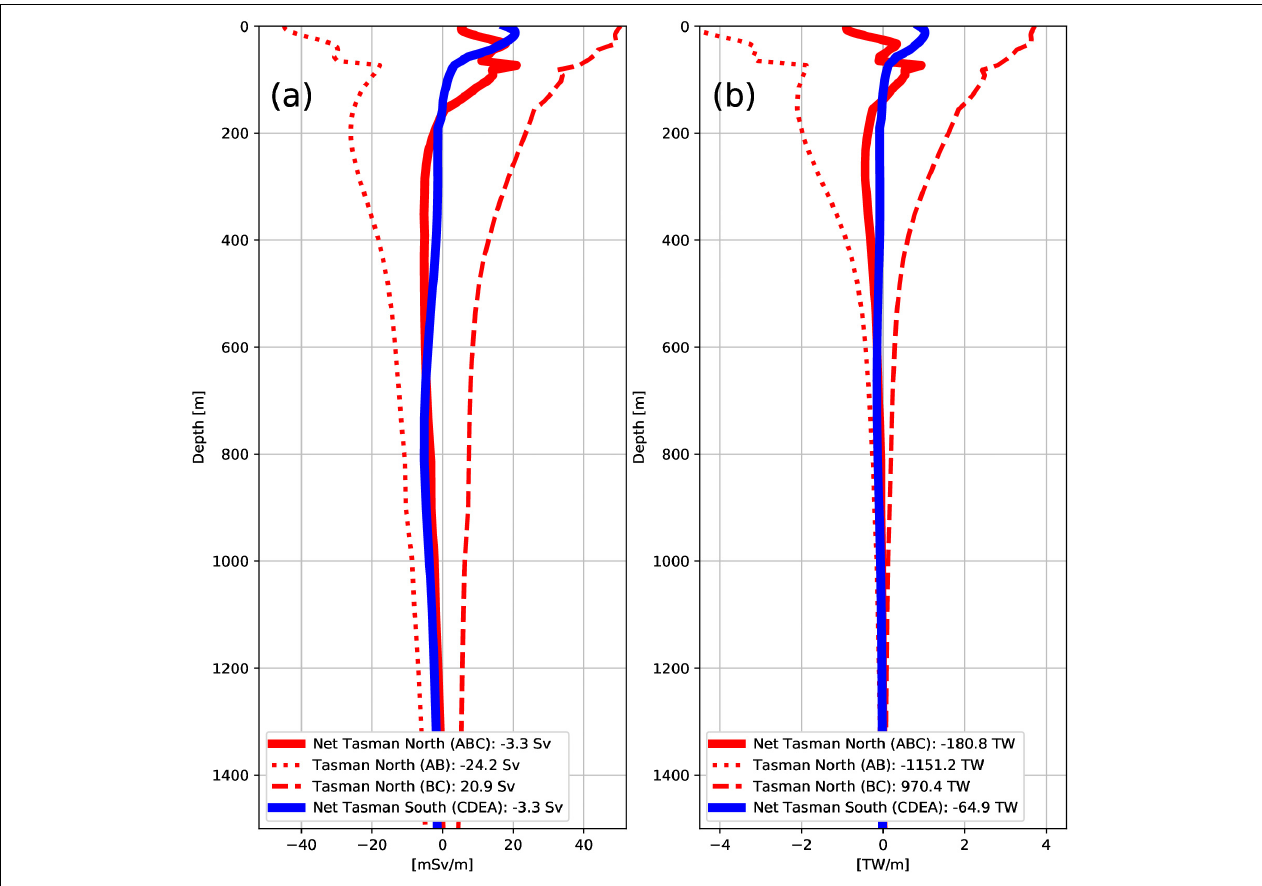
FIGURE 5 | Vertical profiles for time mean (1970–2018) (a) volume and (b) heat transport for sections TN and TS. Red (blue) curves show cross section transports for the Tasman North (South) section. Net transports are shown as solid thick lines. Positive (negative) values for Tasman North (South) reflect transports leaving the Tasman Sea across this boundary. Mean values are provided in the